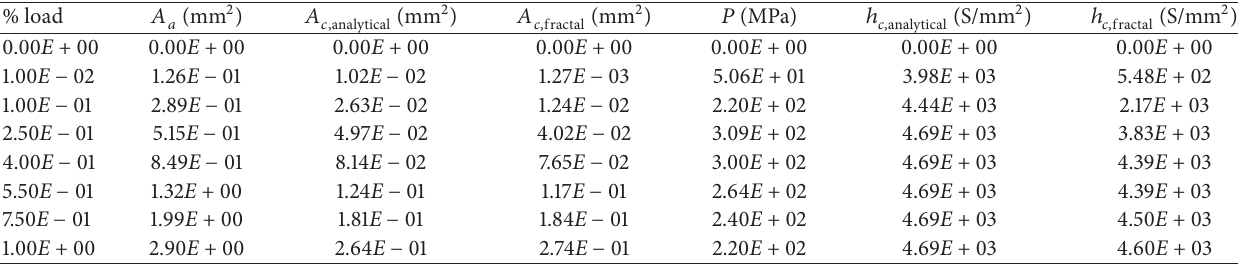
Figure 18: Apparent contact surface at different load levels (at room temperature 𝑇 = 20 ∘ C): 2% (a); 11.6% (b); 18.4% (c); 35% (d); 56% (e); 100% (f). Table 1: Comparison between analytical and numerical